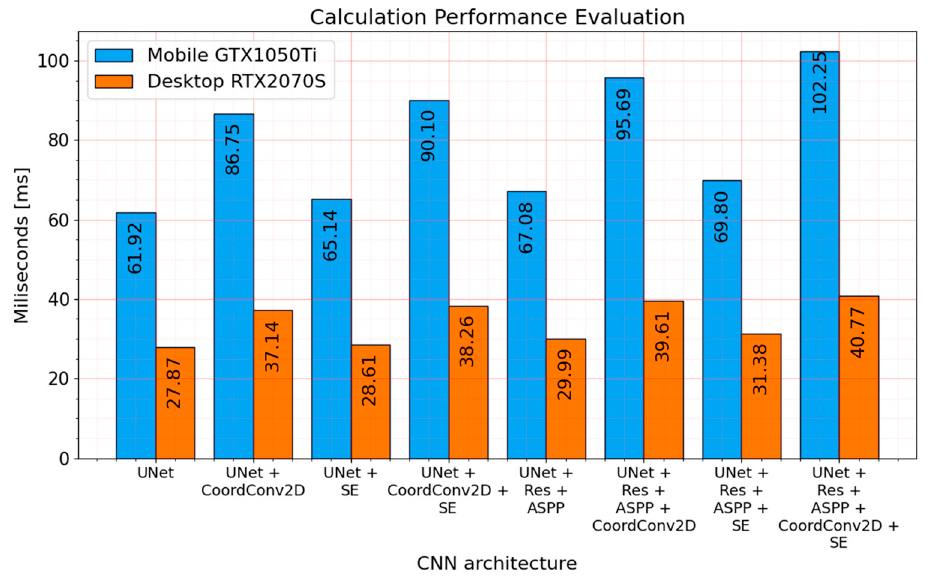
Figure 15. Each convolutional encoder–decoder performance prediction speed on Nvidia GTX1050Ti mobile (laptop) and Nvidia RTX2070 Super (desktop) GPUs. Tensorflow 2.4.0 prebuild from Python PIP package manager is used. Each time is averaged from 1000 forward image passes through the individual model.